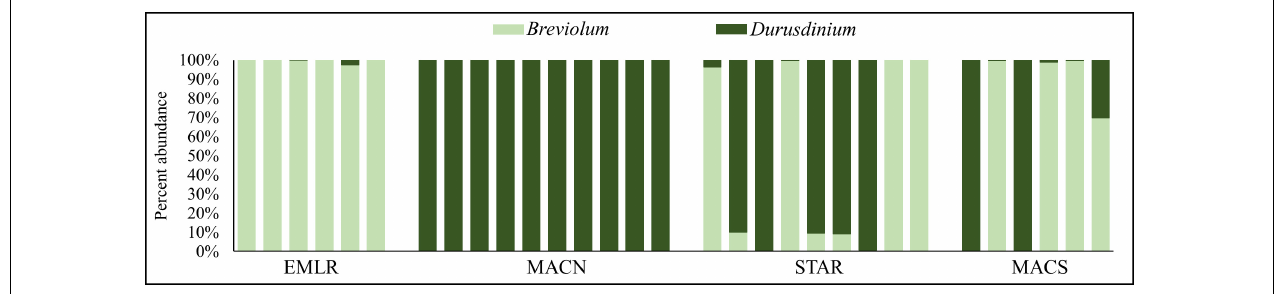
FIGURE 1 | Genus-level endosymbiont composition of 31 individuals of P. strigosa collect from (A) an offshore reef (Emerald Reef, EMLR) and urban coral sites (B) MacArthur North (MACN), (C) MacArthur South (MACS), and (D) Star Island (STAR) near Port of Miami, FL.